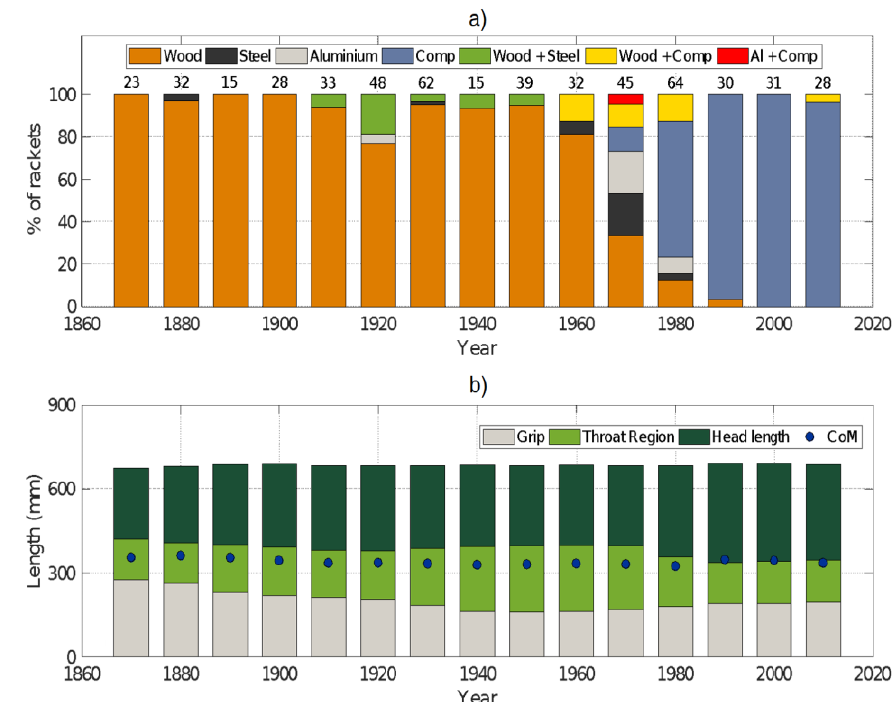
Figure 3. Bar charts showing: ( a ) The percentage of rackets of each material per decade (the values above the columns represent the number of rackets from each decade); and ( b ) the mean length of the grip, throat region and head (ext.) and the CoM location for the rackets per decade.